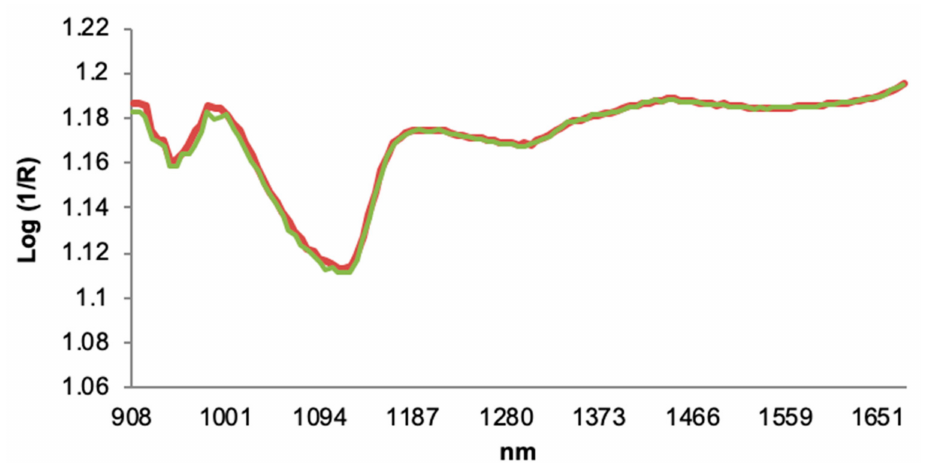
Figure 1. Near-Infrared (NIR) spectra of honey samples recorded by portable